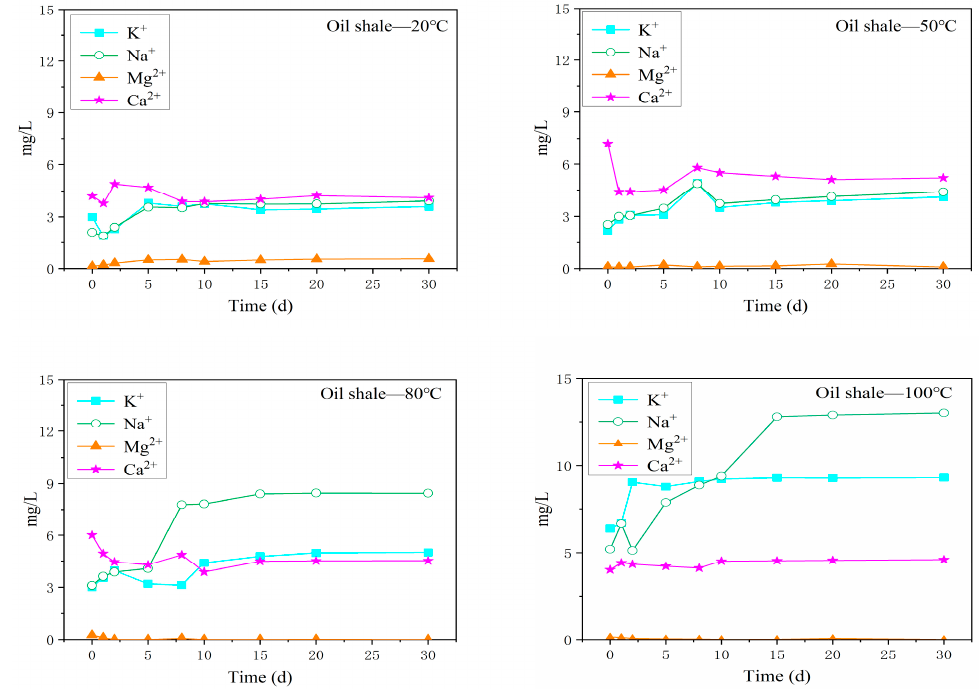
Figure 4. Variations in the content of the main cations in the oil shale aqueous solution under different temperature reaction conditions. Moreover, K + changed little at 20 °C, 50 °C, and 80 °C, but its concentration increased rapidly at 100 °C, indicating that a temperature of approximately 100 °C had the greatest influence on the K + content. The cation content in the aqueous solution tended to be stable at approximately 15 days.